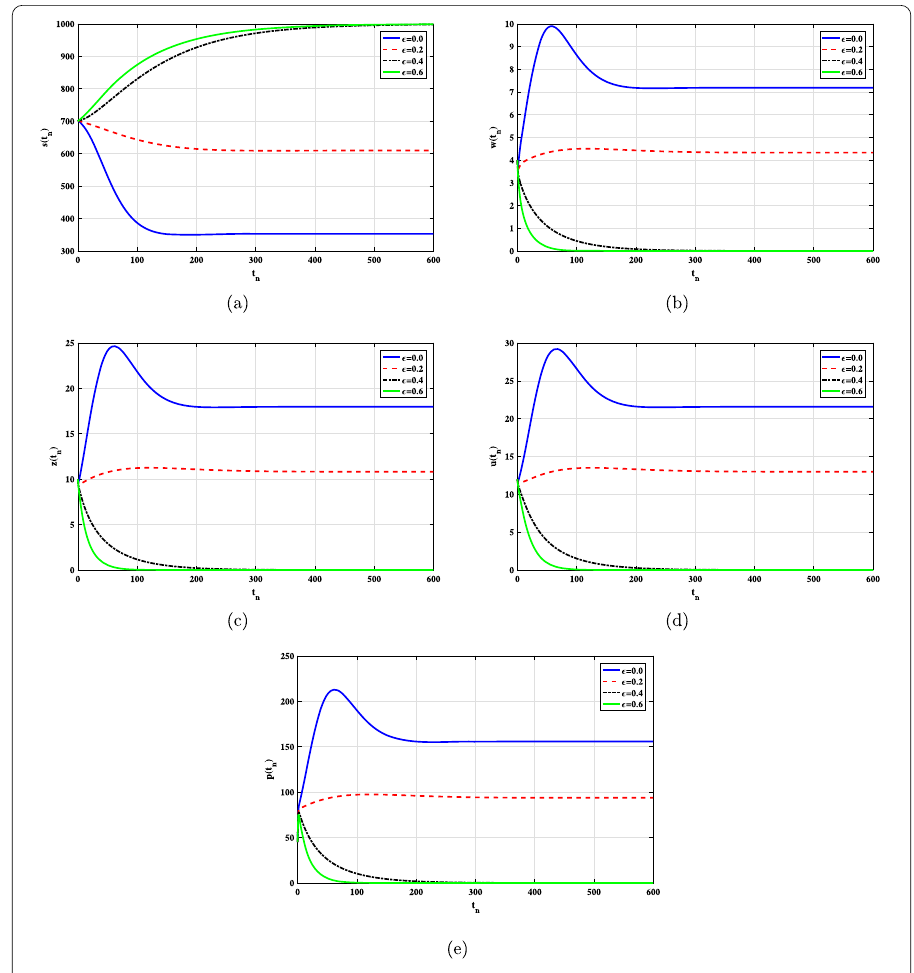
Figure 2 The simulation of trajectories of system (41)–(45) for Case (2)